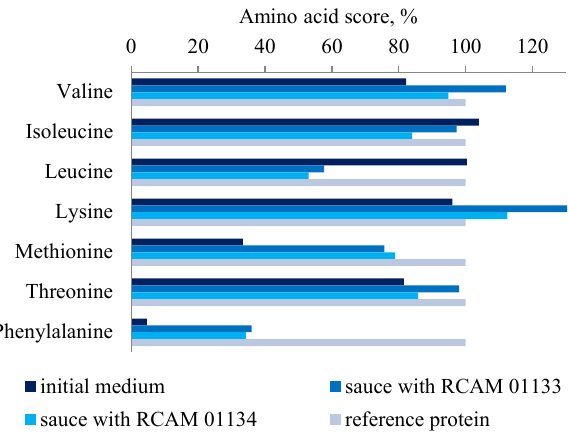
Figure 5 Amino acid scores of initial medium and fermented sources vs. reference protein